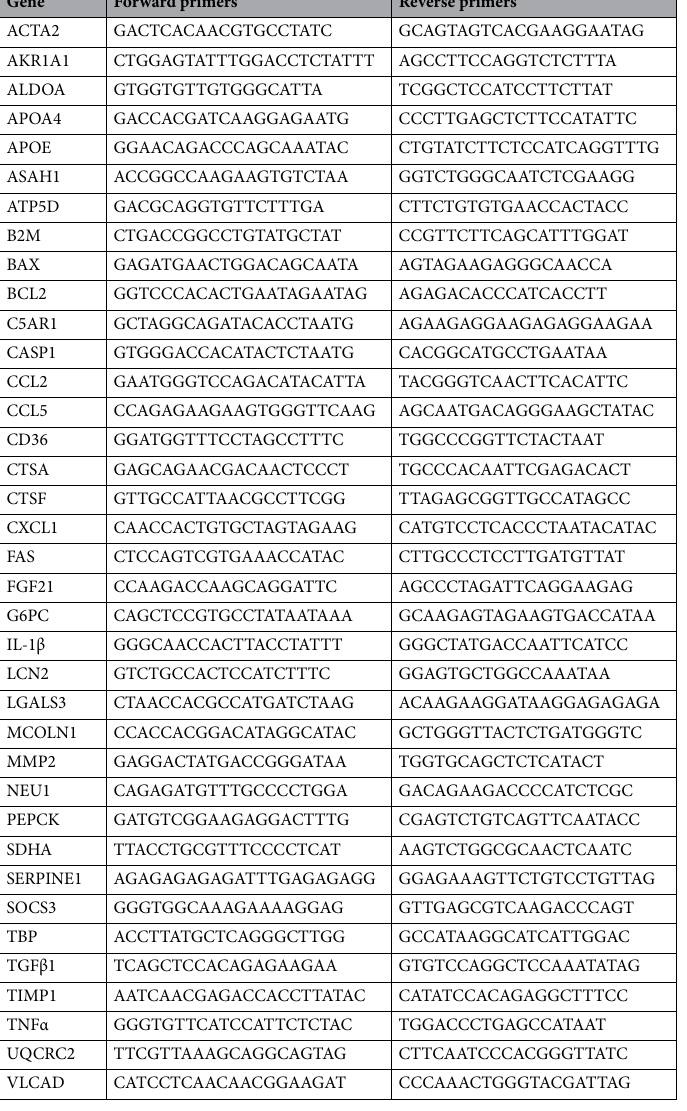
Table 1. List of mouse primers used in RT-qPCR